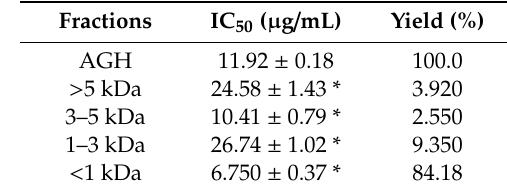
Table 3. Concentrations inducing 50% inhibition (IC 50 ) values for angiotensin converting enzyme, and the yield from Alcalase-generated hydrolysate ultrafiltration from DDSG-PI 1